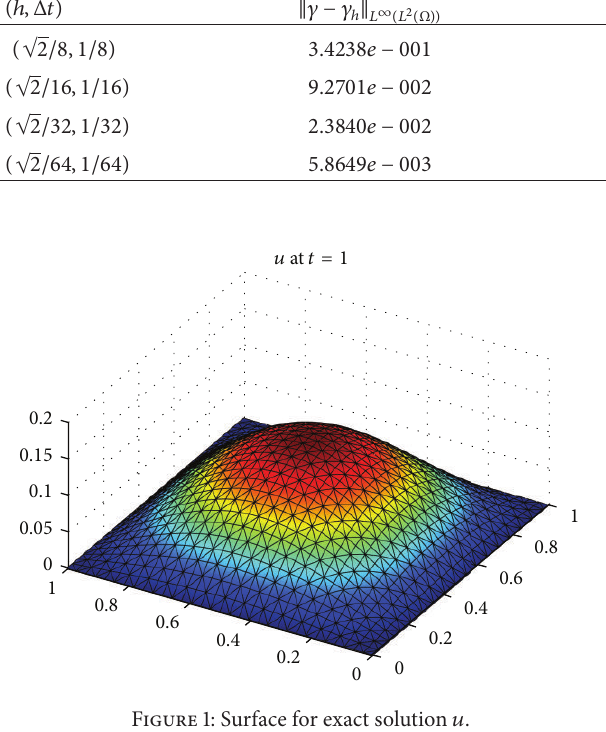
Figure 1: Surface for exact solution 𝑢 .